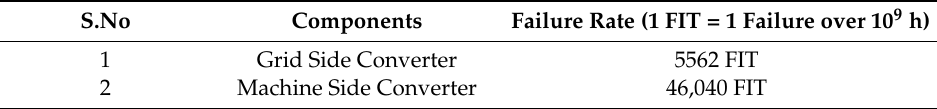
Table 5. Failure rate for sensors [32,34].